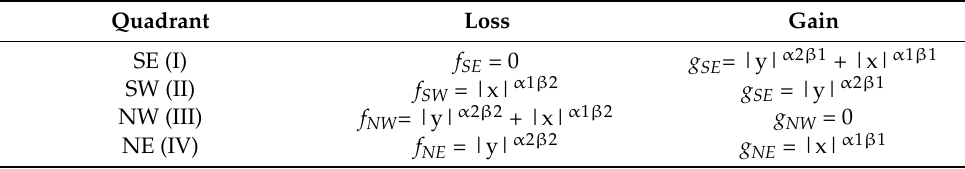
Table 4. Loss and gain function for outcomes in the four quadrants of the DMP. Quadrant Loss